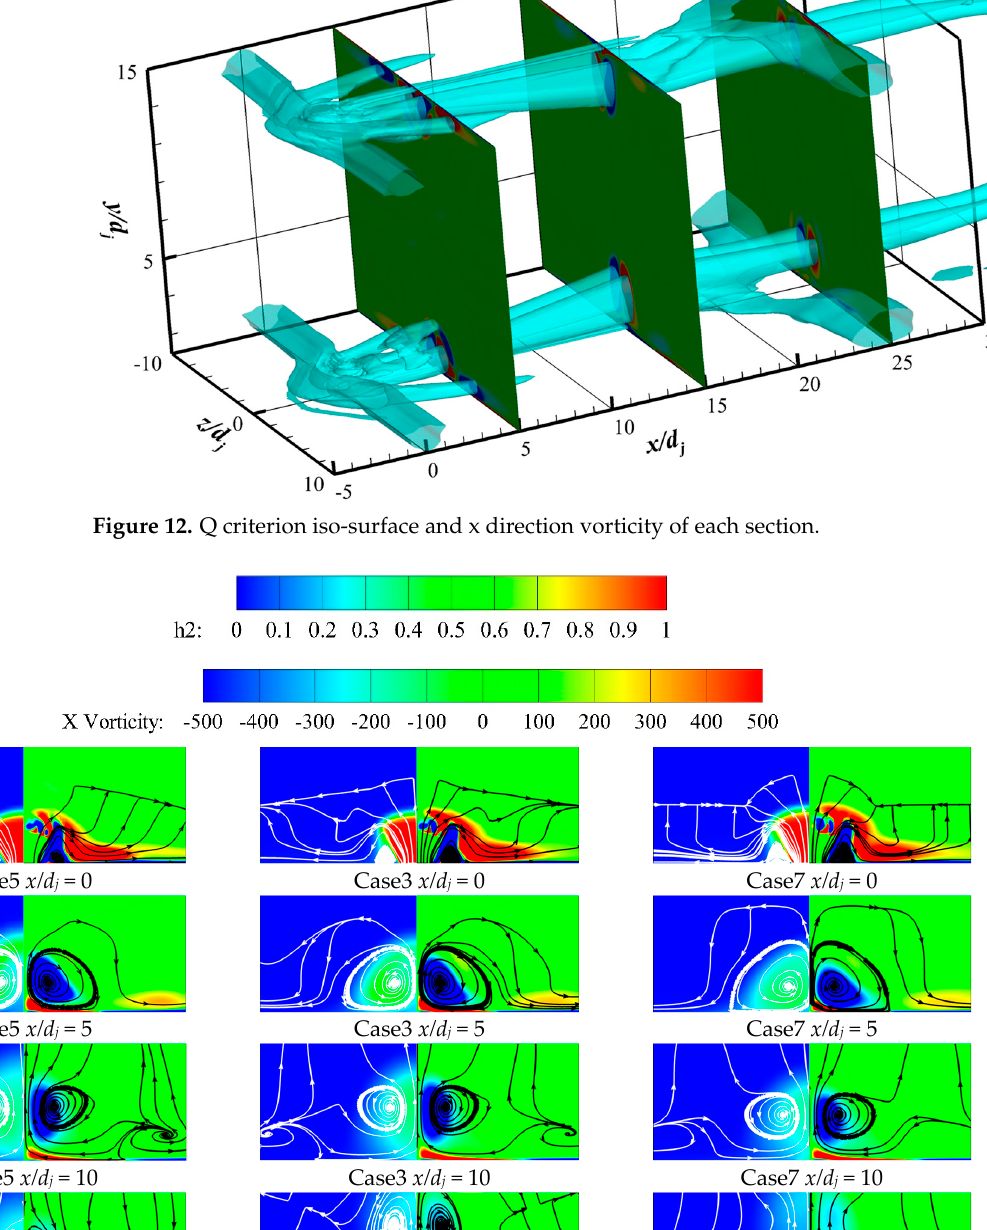
Figure 13. Hydrogen mass fraction and x direction vorticity of Case5, Case3, and Case7 at each sec- tion.